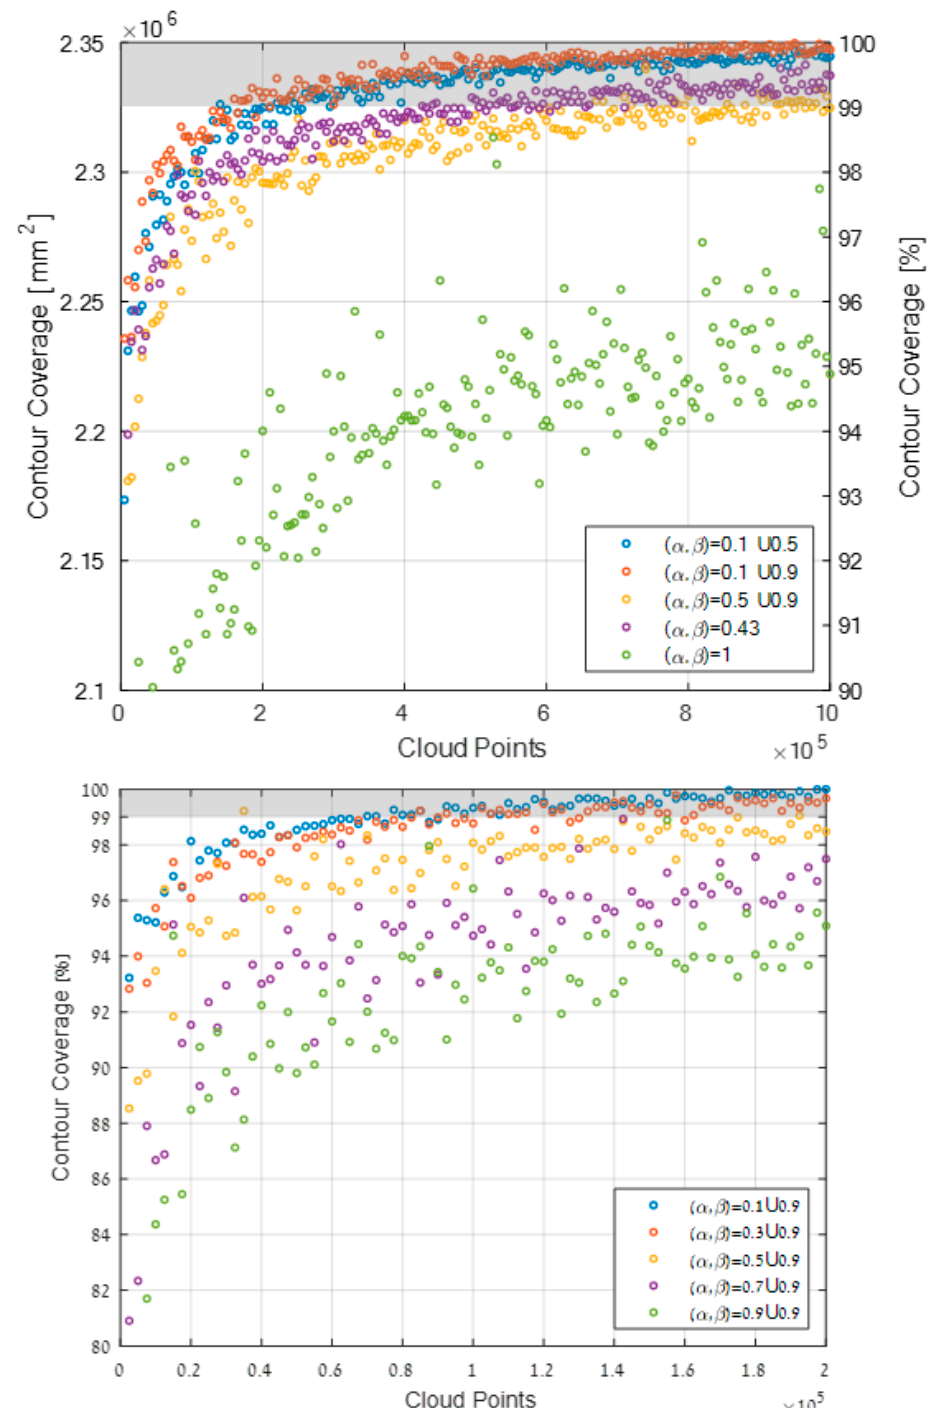
Figure 4. Contour coverage simulation results. Top—different sets of ( α , β ) were combined with low–medium–high values of 0.1–0.5–0.9 and compared to single beta values of α = β = 0.43 and to α = β = 1 (uniform distribution). Bottom—pairs of ( α , β ) values between 0.1 and 0.9 combined with a constant pair with value of 0.9. All simulations were based on the 5R MASR model. These simulations tested the minimal number of cloud points needed to achieve full coverage in case of a 1 m arm, composed of five links. In subcases where the arm has fewer links (or fewer joints that are active), the workspace area will naturally decrease, and a smaller number of cloud points will be needed. To set a criterion for the number of